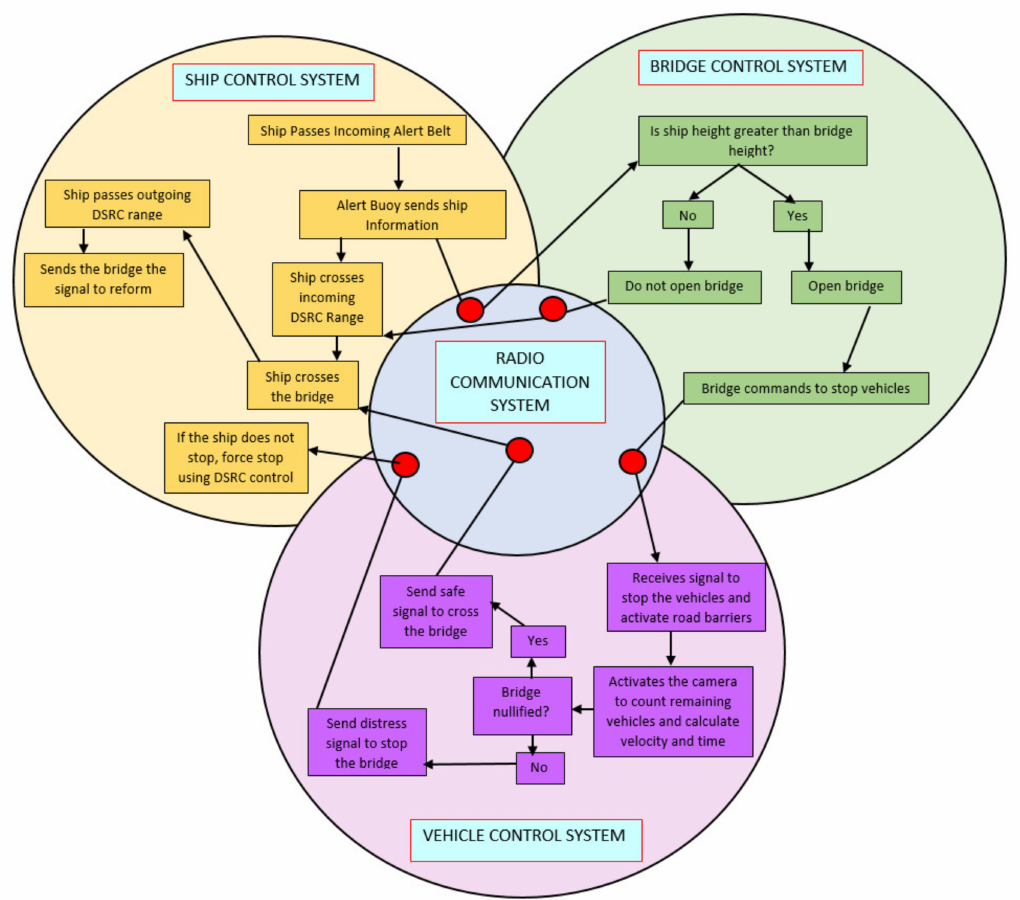
Figure 5. Relationship diagram for the three control systems in ships, vehicles, and